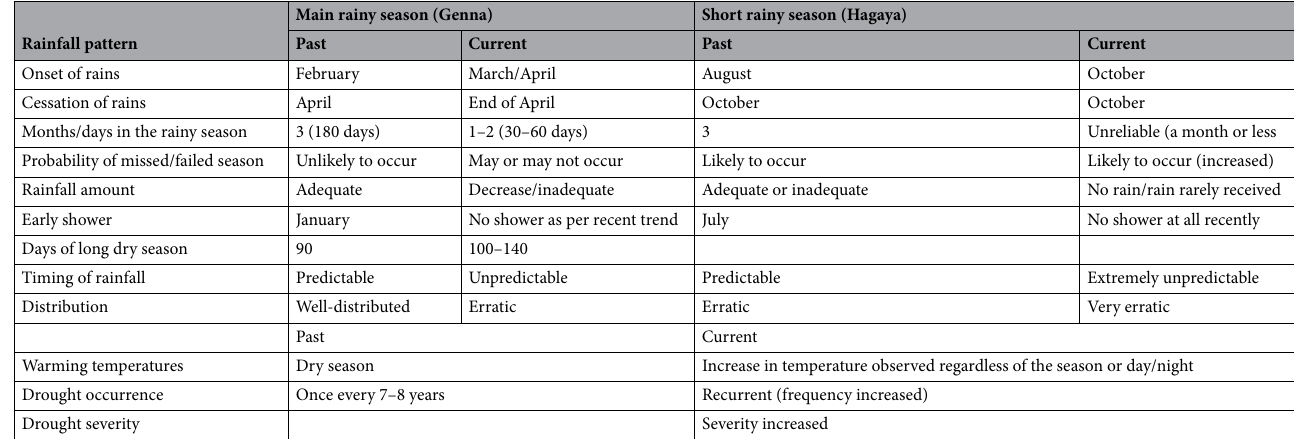
Table 10. Comparisons of past and current climate variabilities and change parameters. Source: Key Informants Interview, July–August